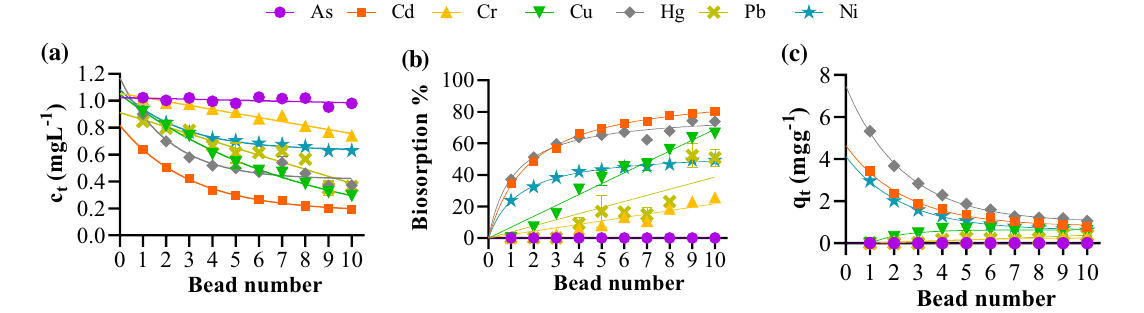
Fig. 7 Effect of an increase in bead number. One to ten beads were incubated in a cocktail solution containing all seven ions each at 1 mgL-1 at pH 7.0, 25 °C with continuous shaking at 250 rpm for 10 h.